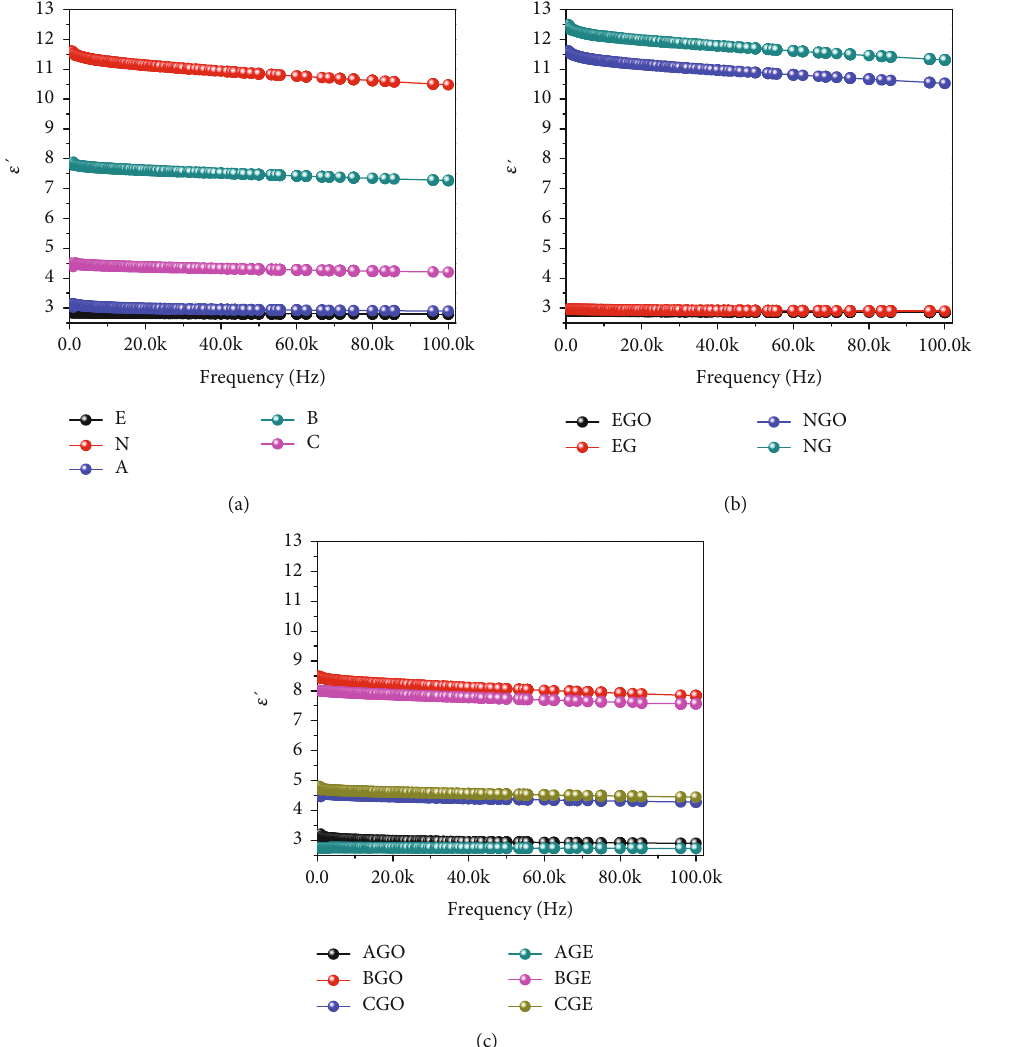
Figure 9: The e ff ect of frequency and fi ller on the dielectric constant of (a) un fi lled single and double matrix, (b) single matrix- fi lled GO and G, and (c) double matrix- fi lled GO and